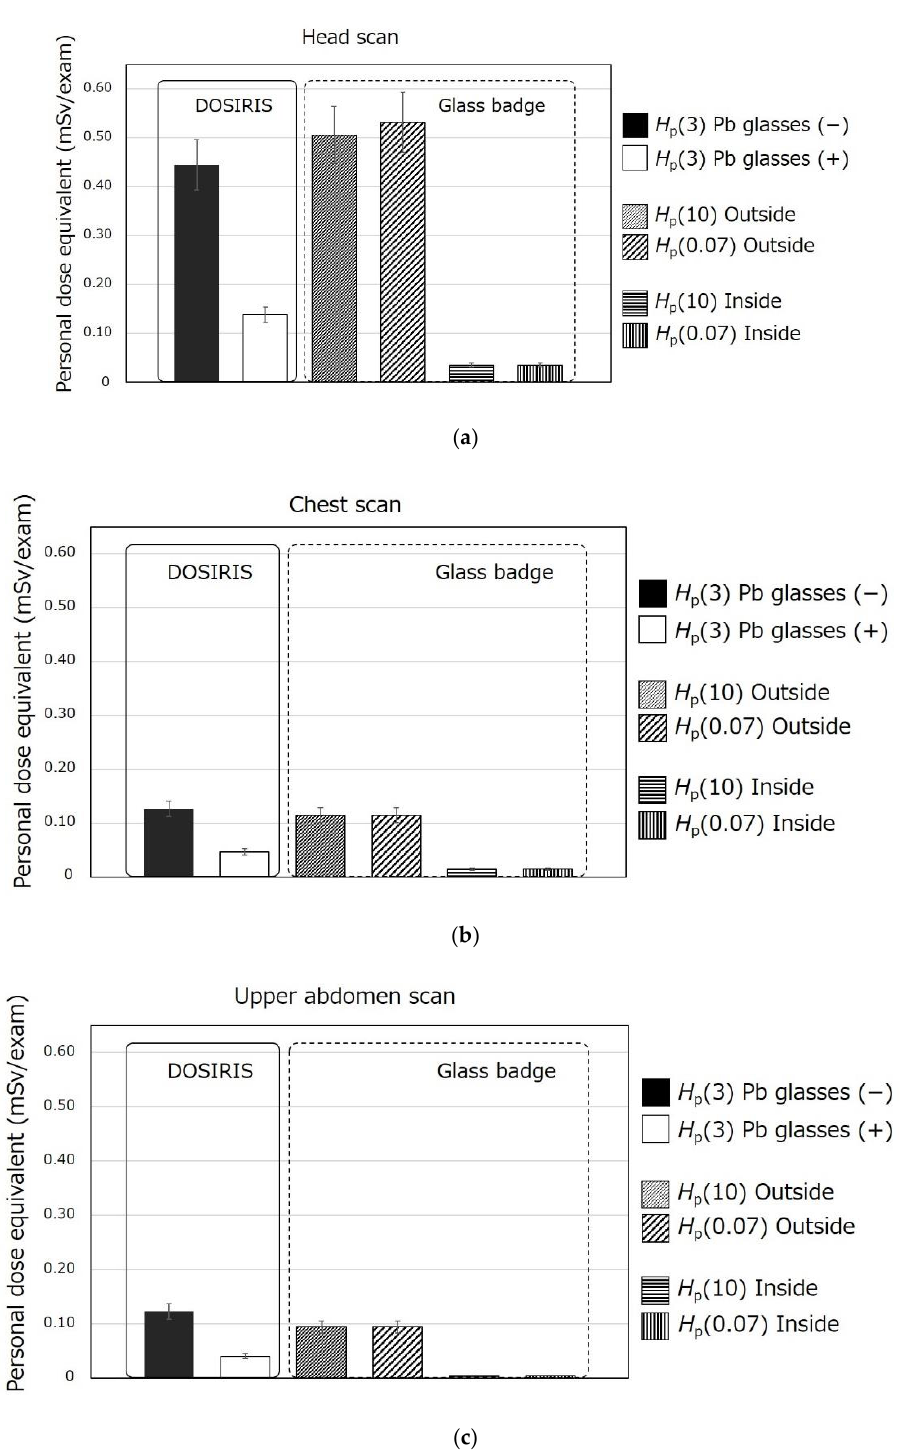
Figure 3. Personal dose equivalent in ( a ) head scan, ( b ) chest scan and ( c ) upper abdomen scan. Pb glasses (−) and Pb glasses (+) denote without Pb glasses and with Pb glasses, respectively. The error bars indicate the uncertainty of the measured value.